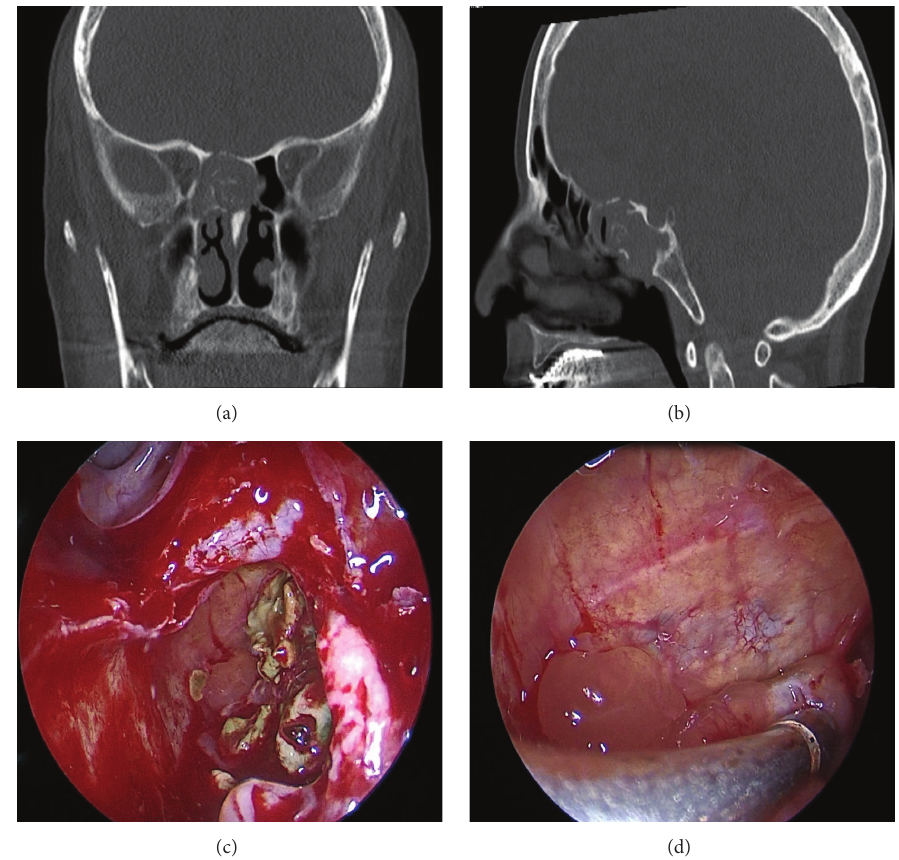
Figure 3: (a, b) Paranasal sinus computed tomography of a soft tissue mass filling the right posterior ethmoidal cells and sphenoid sinus. (c) Endoscopic view of the yellow-green colored caseous material in the right sphenoid sinus. (d) Endoscopic view of the intact dura mater in the right sphenoid